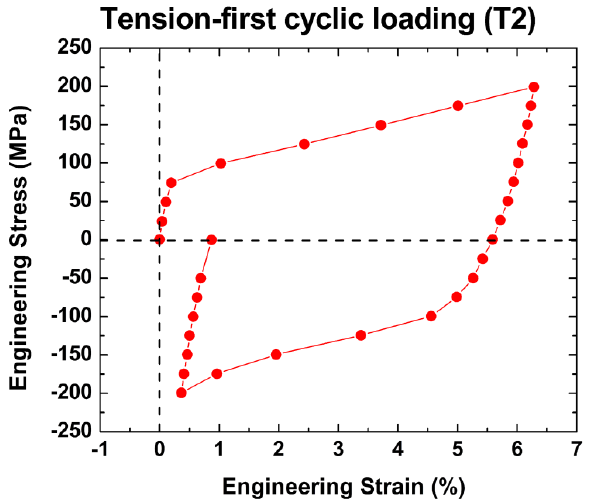
Figure 5. Macroscopic stress-strain response for the T2 sample. The symbols correspond to points in the loading history at which diffraction data were